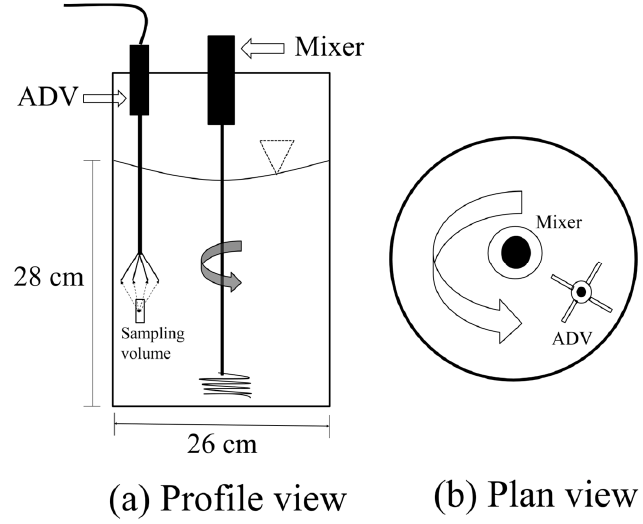
Figure 2. Experimental setup in laboratory. Table 1. Summary of sand sizes and concentrations for which acoustic backscatter data were collected (+ and - signs indicate the availability and unavailability of the data, respectively) for experiments with well-sorted sands. Construction sand was sieved to yield the various size fractions.